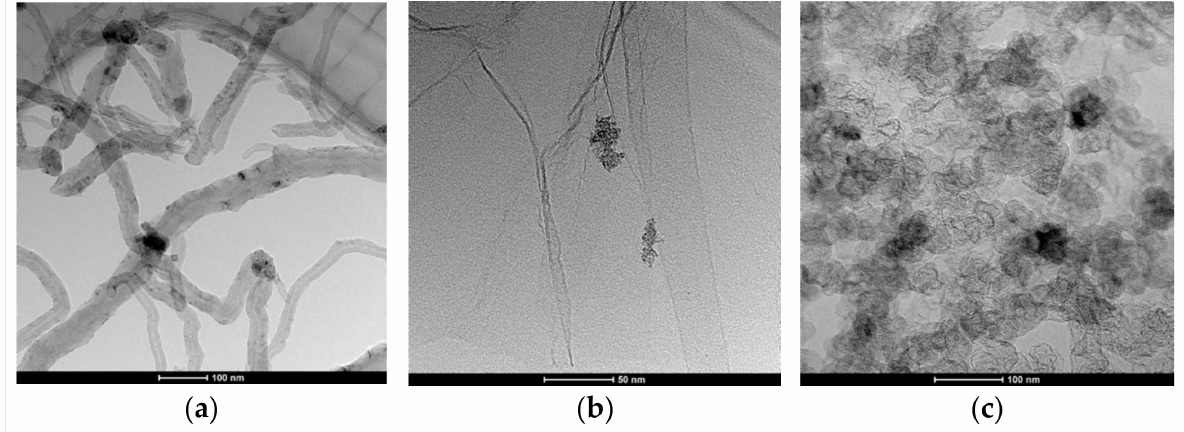
Figure 3. TEM scans of ( a ) NT + RuO 2 , ( b ) GR + RuO 2 , and the ( c ) CB + RuO 2 layer.